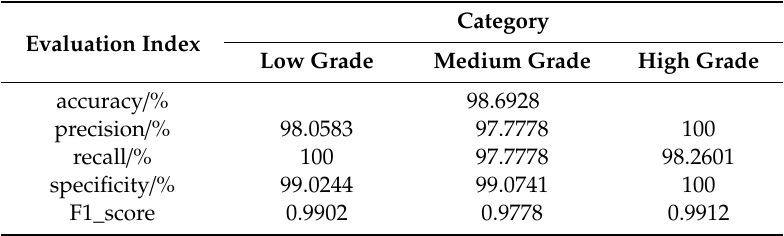
Table 4. Evaluation index.